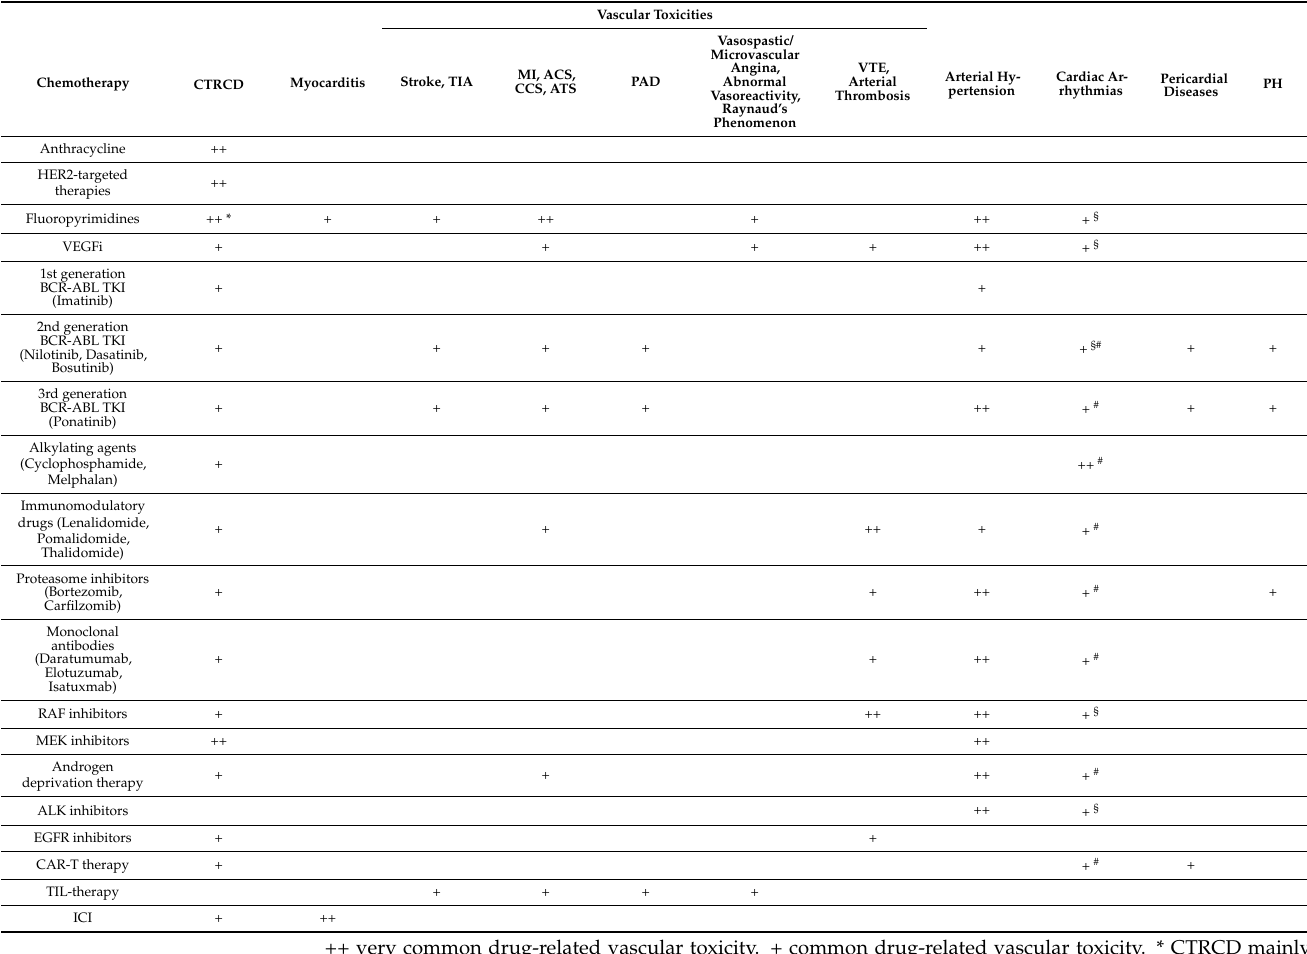
Table 1. Chemotherapy-related cardiovascular toxicity